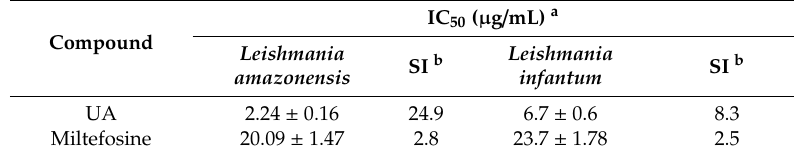
Table 2. In vitro leishmanicidal activity of UA on Leishmania intracellular amastigotes. Miltefosine was used as the reference